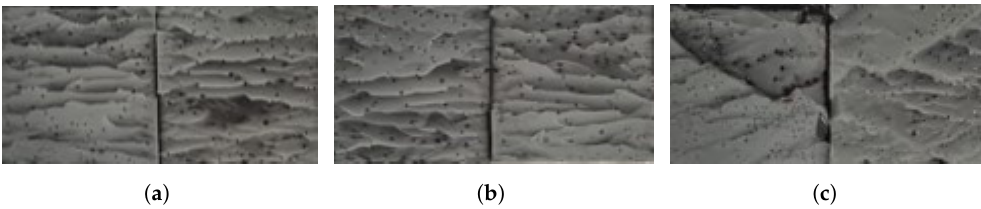
Figure 21. Fracture surfaces of dry joints with PBT-GF30 substrates with 0.5 mm ( a ), 1 mm ( b ), and 2 mm ( c ) of adhesive